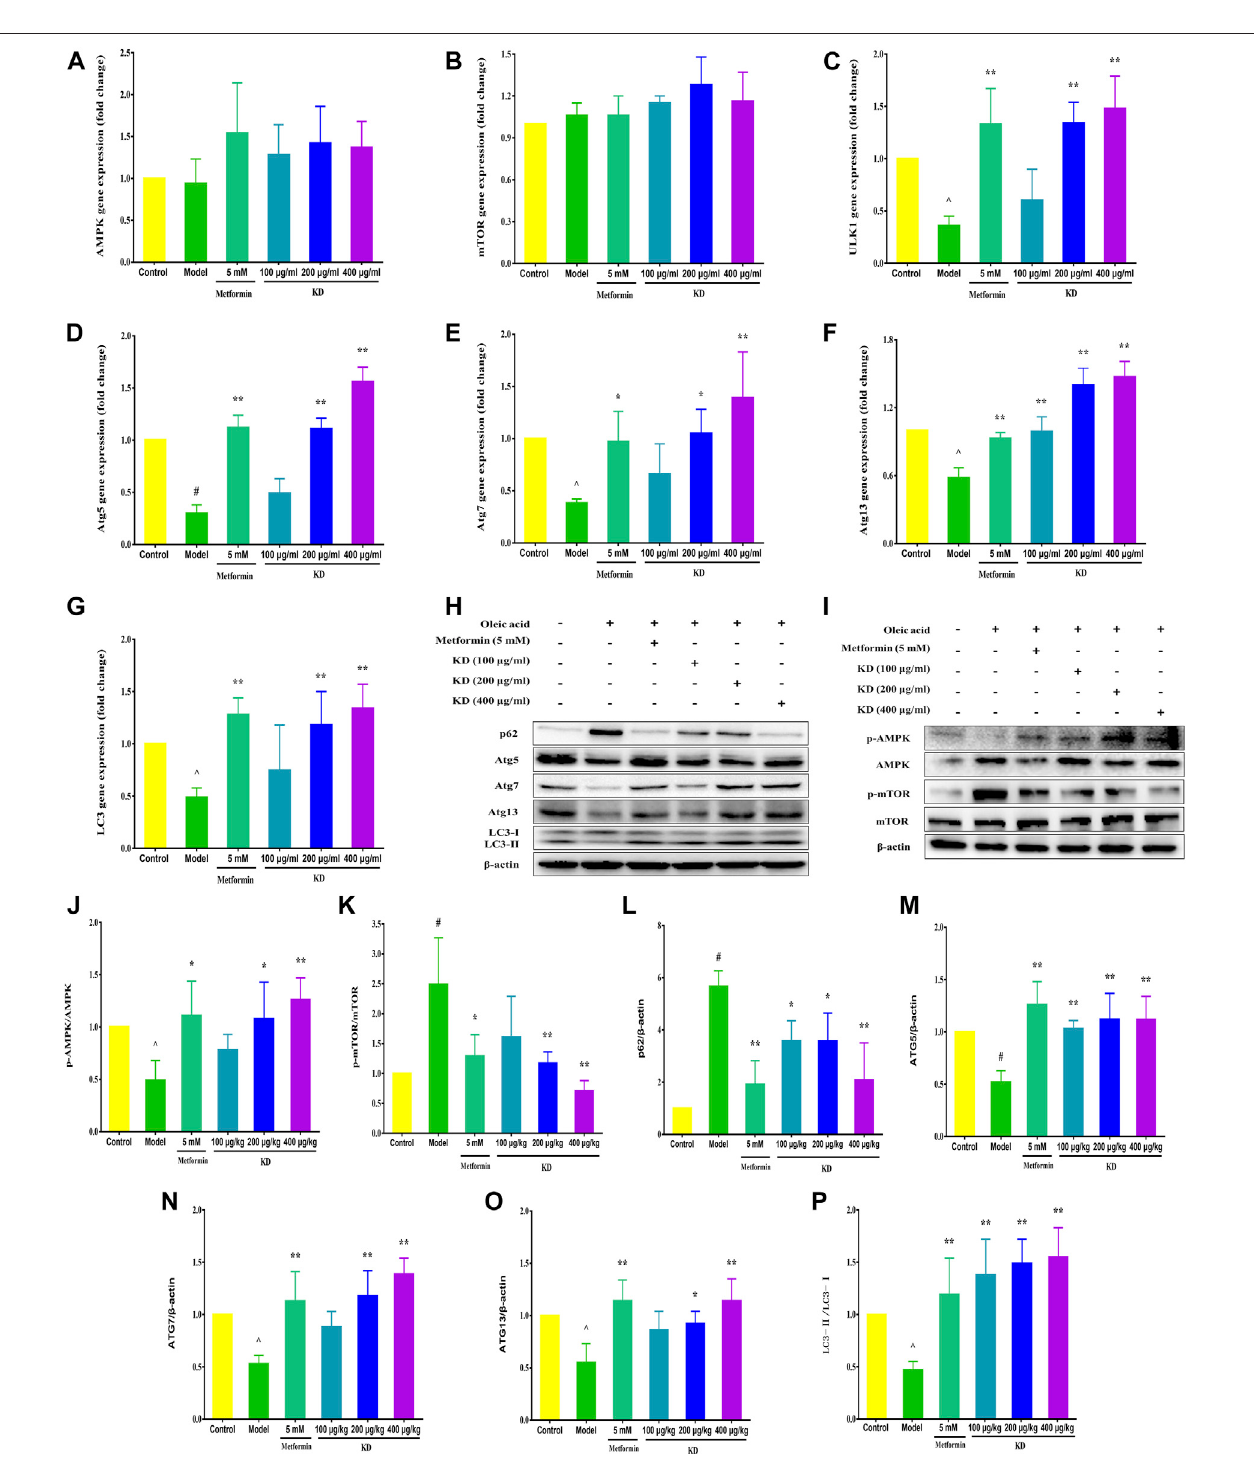
FIGURE 5 | KD enhances the expressions of autophagy-related proteins and genes in insulin-resistant cells. LO2 cells were incubated in DMEM with 0.5% fatty acid-freeBSAoroleicacid(0.25 mM)inthepresenceofKD(100,200and400 μ g/ml)ormetformin(5 mM)for24 h.TheexpressionsofAMPK (A) ,mTOR (B) ,ULK1 (C) , Atg5 (D) ,Atg7 (E) ,Atg13 (F) andLC3 (G) genesinhepatocyteswereanalyzed. (H – P) WesternblotanalysisforAMPK,p-AMPK(Thr172) (J) ,mTOR,p-mTOR(Ser2448) (K) ,p62 (L) ,Atg5 (M) , Atg7 (N) ,Atg13 (O) and LC3- Ⅱ / Ⅰ (P) . Datawere presented asmean ± SD ( n (cid:2) 3in each group). # P < 0.01 compared withthecontrolgroup, * P < 0.05, ** P < 0.01 compared with the model